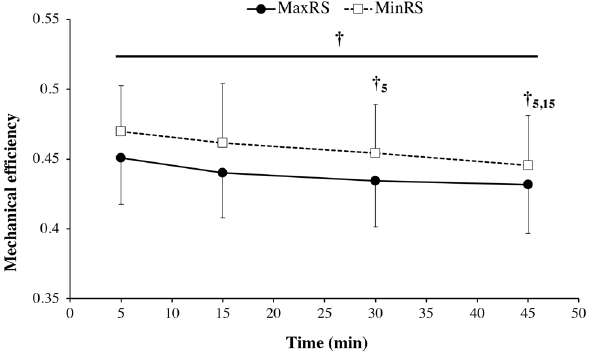
Figure 4. Mechanical efficiency versus time during the two experimental conditions [traditional cushioned (TrdRS) and minimalist (MinRS) running shoes]. Values are mean ± SD (n = 16). † denotes a significant time effect ( P ≤ 0.05); † 5 indicates a significant difference from 5 min; † 15 represents a significant difference from 15 min.